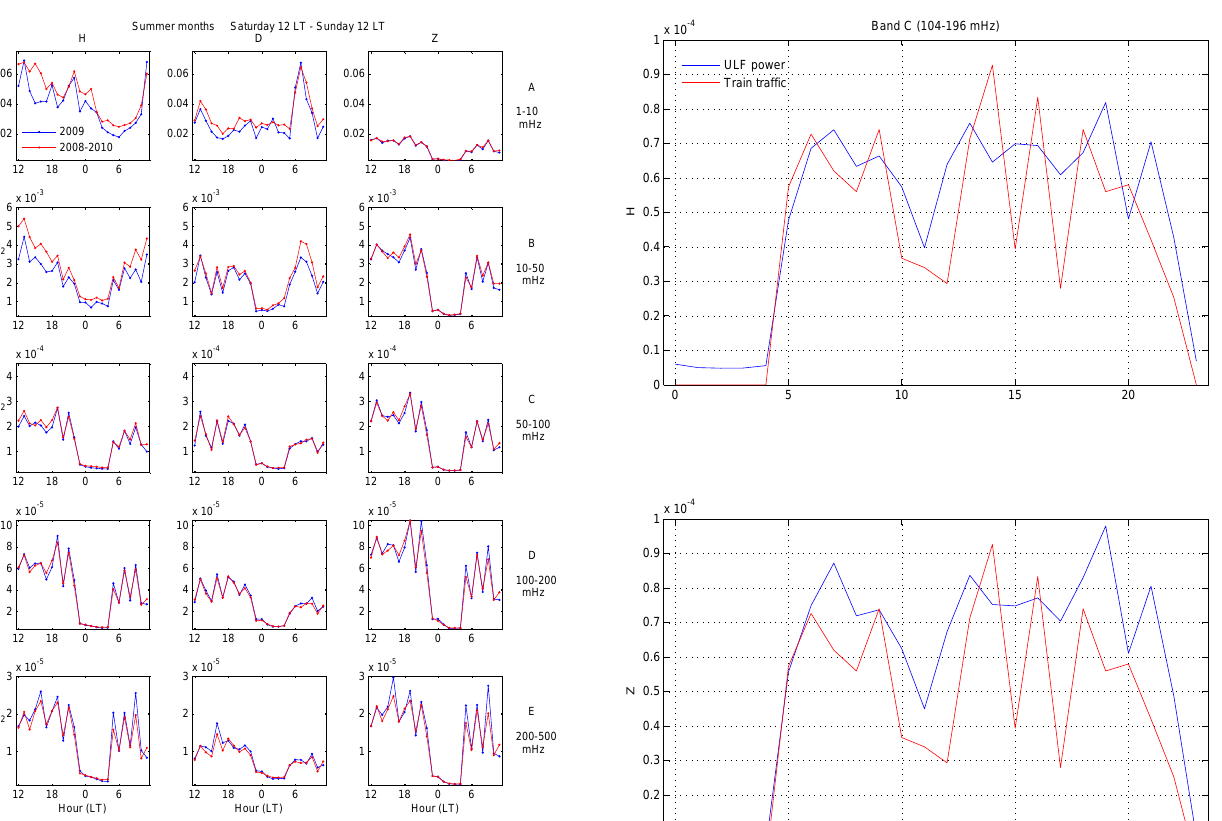
the train transit at the closest railway segment. As shown in Fig. 7, the trace of the estimated noise (arbitrary scale) re- veals a general correspondence with the observed LT depen- dence of the power level in the H and Z components; it is worth noting that, in agreement with experimental observa- tions, trains (28 per day during Monday through Friday) are absent in the entire midnight interval (23:00–05:00 LT) and their number decreases between 10:00 and 13:00 LT. In ad-